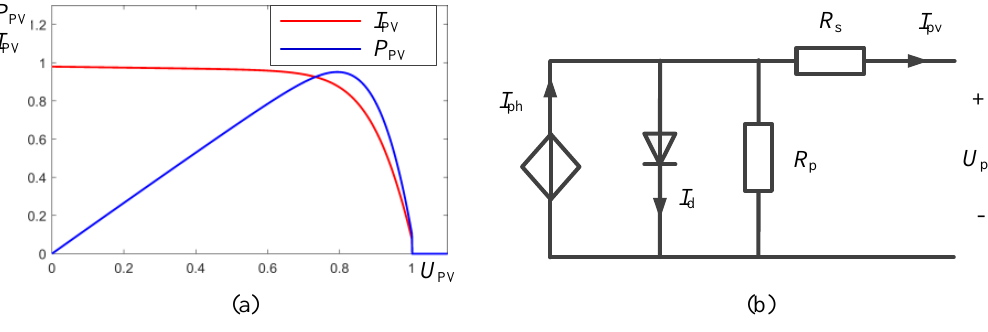
Figure 2. ( a ) PV array characteristic; ( b ) PV array model.